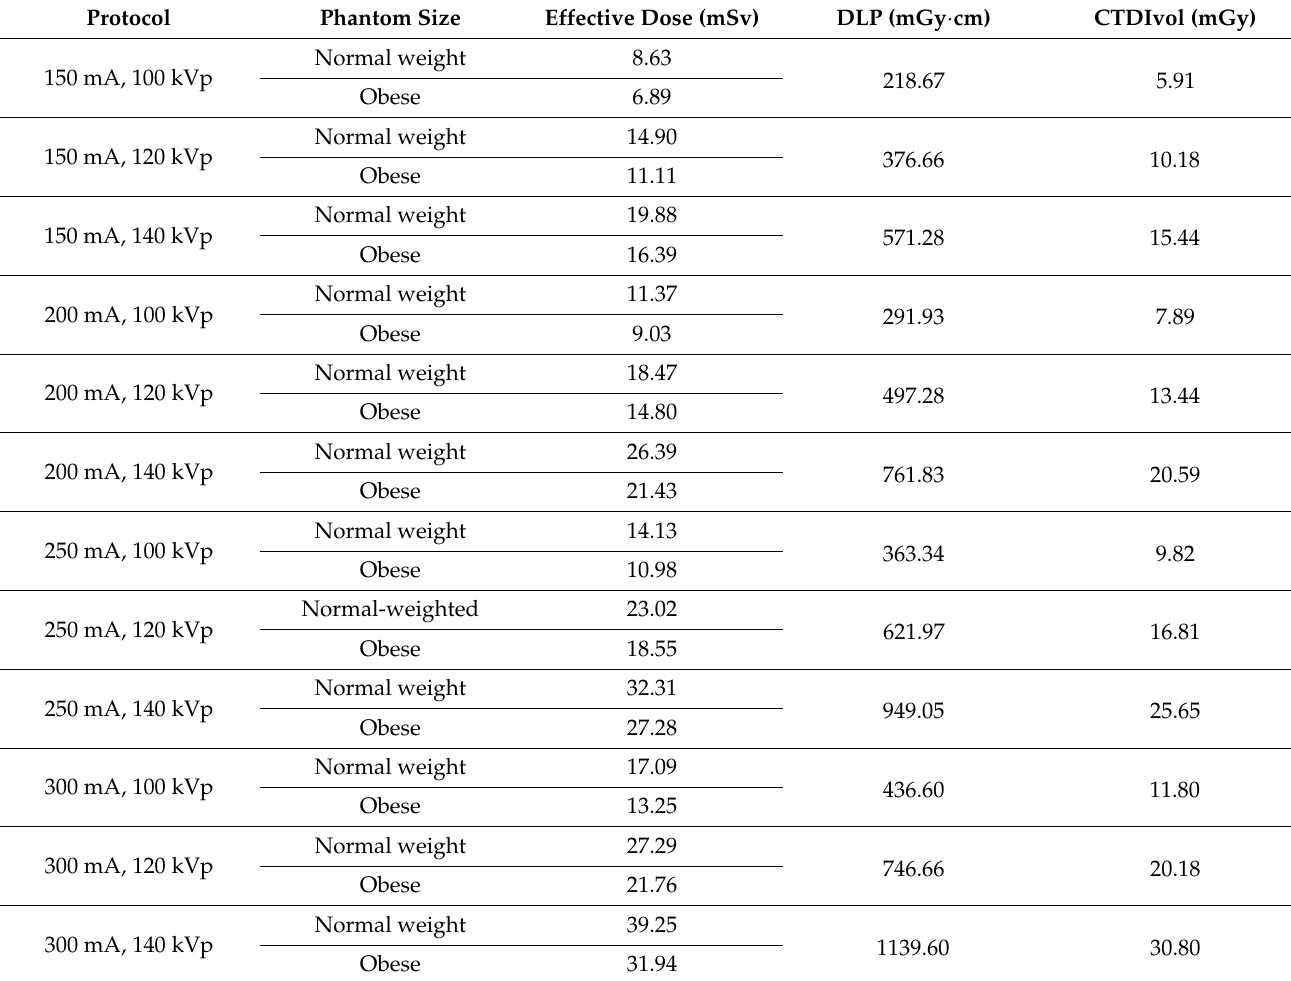
Table 4. Effective dose in millisievert (mSv), dose length product (DLP) in milliGray-Centimeter (mGy · cm), and volume CT dose index (CTDIvol) in milliGray (mGy) values for both phantoms (normal-weighted and